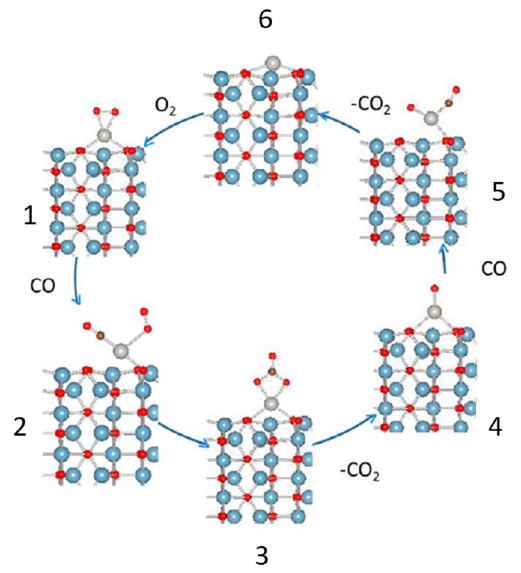
Figure 18. A catalytic cycle derived theoretically by Moses-DeBusk et al. [167] for the oxidation of CO by O 2 mediated solely by isolated Pt atoms supported upon a theta-Al 2 O 3 surface and involving the transient formation of a bidentate Pt(CO 32 − ) species (VI). Grey = Pt, red = O, brown = C, blue = Al. 1 shows the starting oxidized Pt atom adsorbed upon the Al 2 O 3 to which CO may add to eventually form an adsorbed bidentate carbonate ( 3 ). This carbonate then decomposes that loses CO 2 to form a new adsorbed PtO ( 4 ) that can react with a second CO molecule to eventually release a second CO 2 molecule and form a third atomic Pt species ( 6 ) to which O 2 can add. Reproduced with permission from J. Am. Chem. Soc. 2013 , 135 , 12634–12645 [167]. Copyright 2013, American Chemical Society.